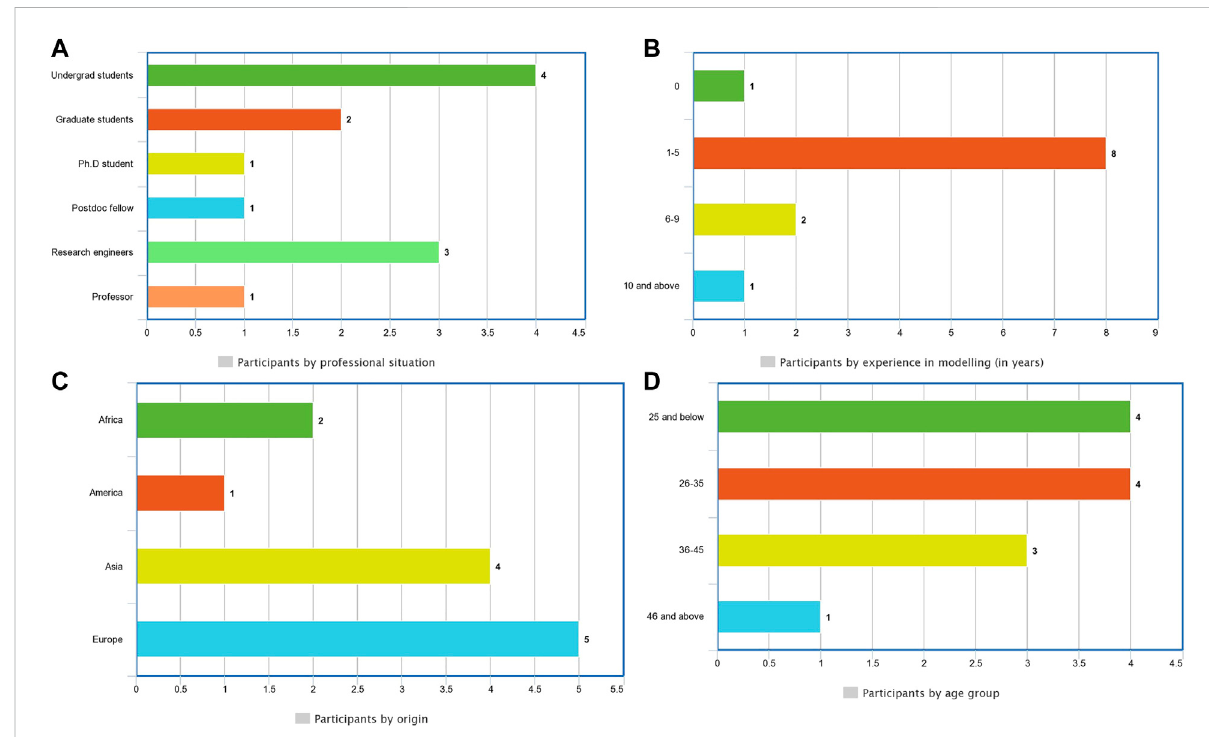
FIGURE 10 Overview of the participants in terms of professional situation (A) , experience in modeling (B) , origins (C) , and age groups (D)